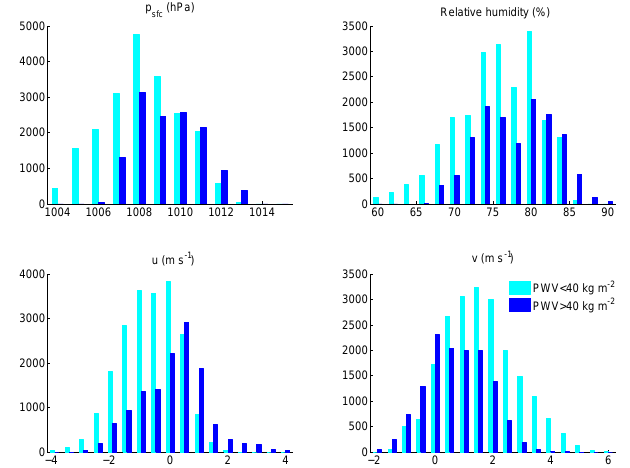
Figure A1. Distributions of minute-resolution MCOH variables for low (PWV < 40kgm − 2 , cyan) and high (PWV > 40kgm − 2 , blue) water vapor conditions. Dry cases on average correspond to a lower surface pressure, lower surface humidity, and faster surface wind speed in both north–south (northerly) and east–west (westerly) di- rections.